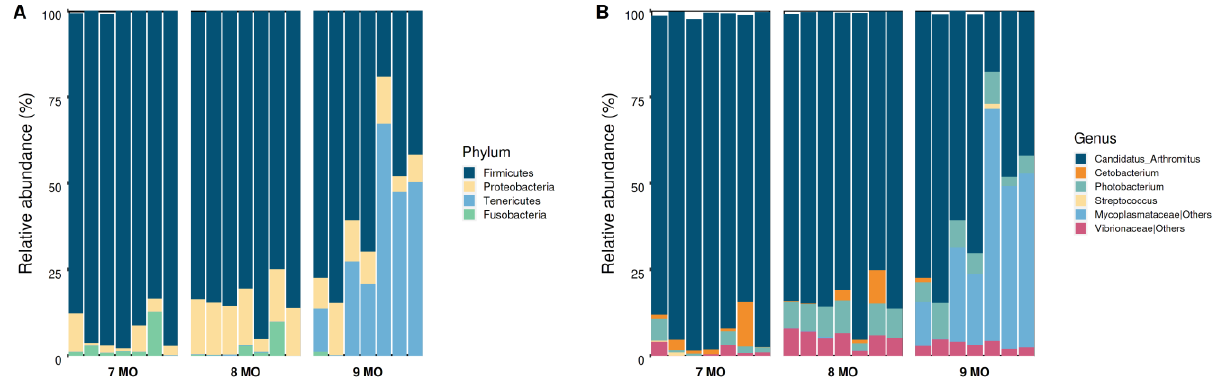
Figure 1. Relative abundance distributions of bacterial phyla ( A ) and genera ( B ) assignable to amplicon sequence variants (ASVs) from intestinal microbiota of Seriolella violacea . Those components with relative abundance > 0.5 % in at least one sample were considered.